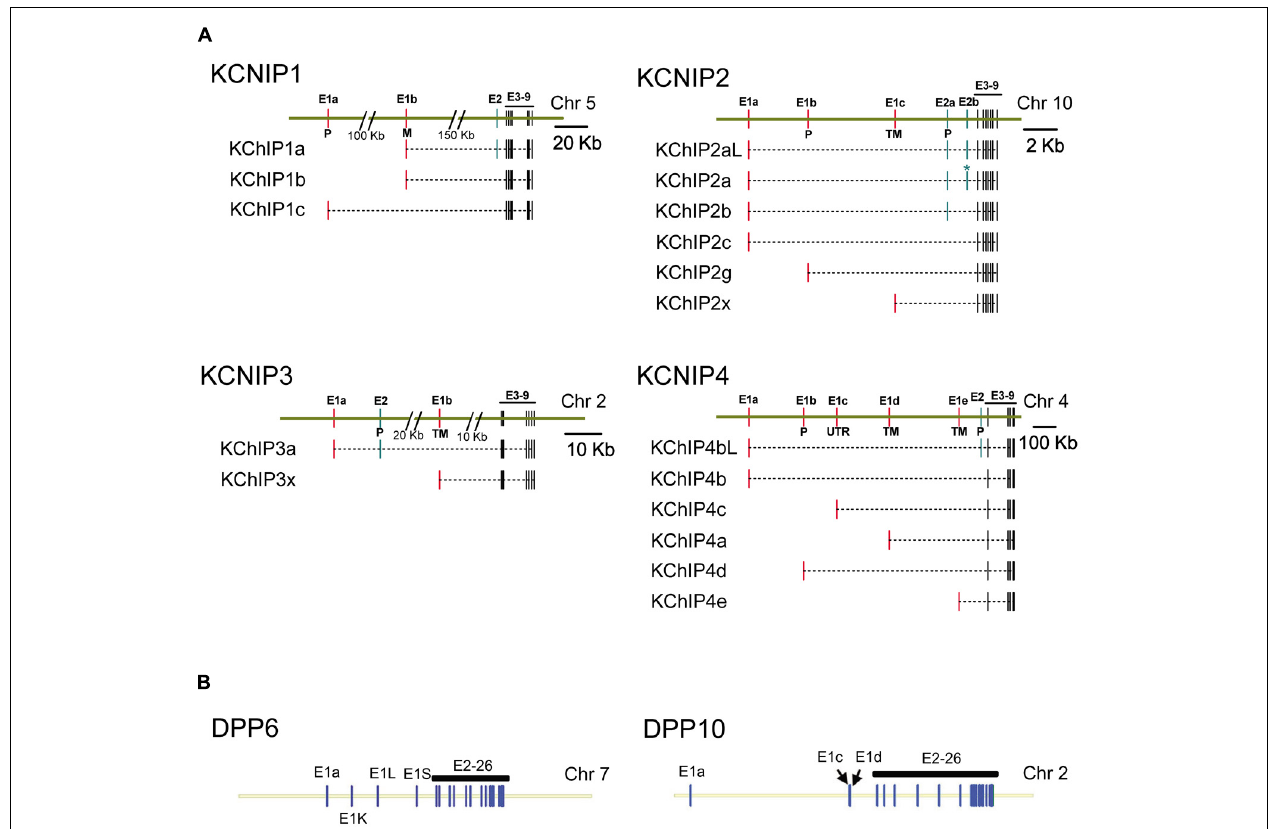
FIGURE 2 | Genomic structure of KChIP and DPLP genes. Gene structures for Kv4.2 auxiliary subunit proteins show a common core with variable N-terminal exons. (A) KChIP genes show a common set of 3 (cid:3) exons 3–9 with 1 to 2 alternative 5 (cid:3) exons used to construct the final mRNA transcript. (B) DPLP genes show a common set of 3 (cid:3) exons 2–26 with alternative 5 (cid:3) first exons. Maps were constructed using exon locations in human chromosomes as given in Concensus CDS data base (http://www.ncbi.nlm.nih.gov/CCDS) or determined